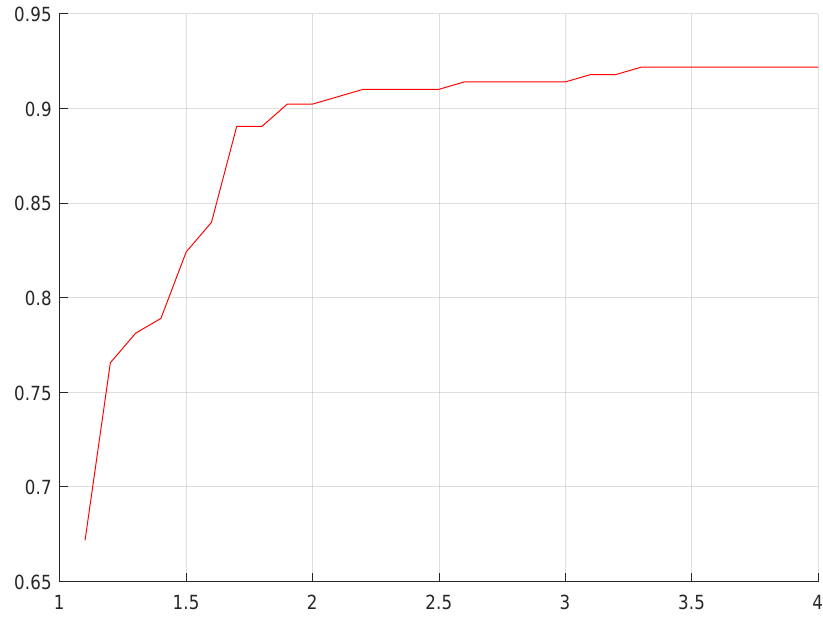
Figure 8. x -coordinate is the value of α / β and the y -coordinate is the proportion of all nodes of the simulated routing protocol and GEM routing protocol that are in same hops from the station. When α / β = 2, the proportion is larger than